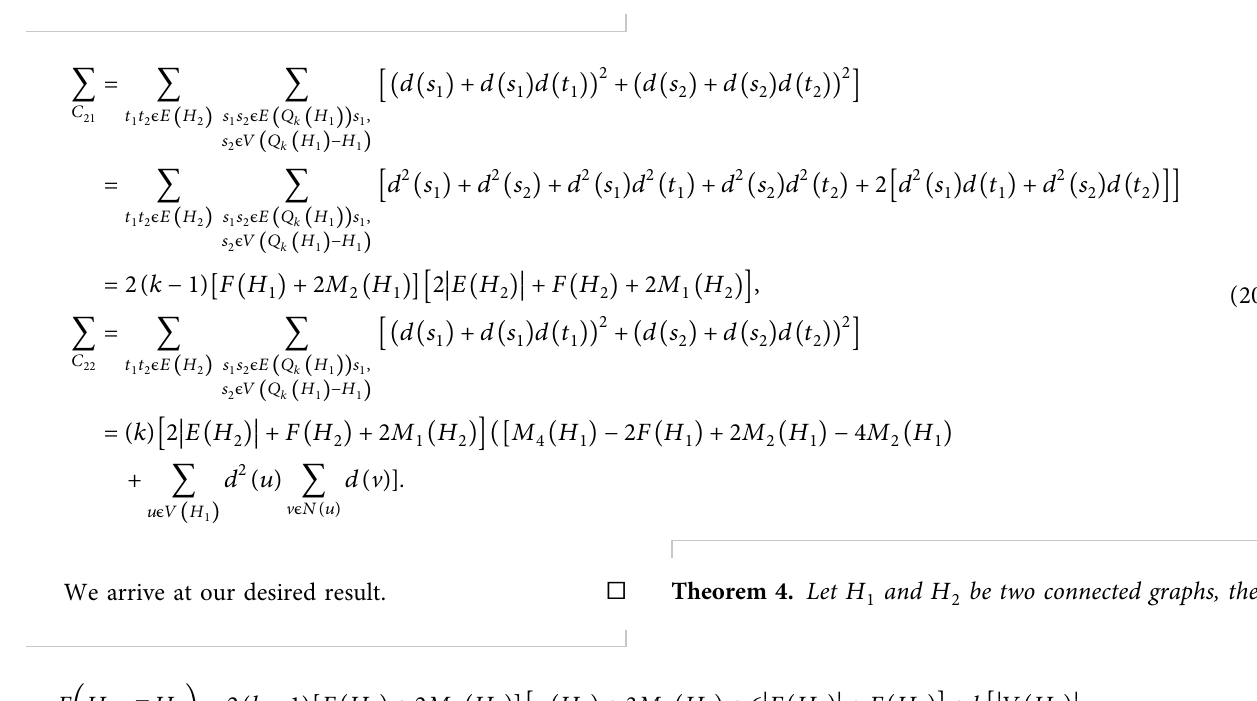
Table 2: F -index of F